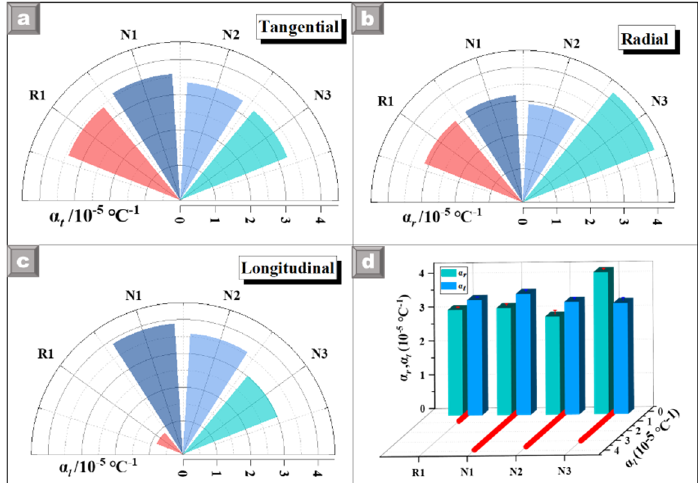
Figure 10. Results of Thermal linear expansion test of the archaeological wood. ( a ) Thermal linear expansion coefficient along the tangential direction. ( b ) Thermal linear expansion coefficient along the radial direction. ( c ) Thermal linear expansion coefficient along the longitudinal direction. ( d ) Comparison of expansion coefficients along and across the grain direction.